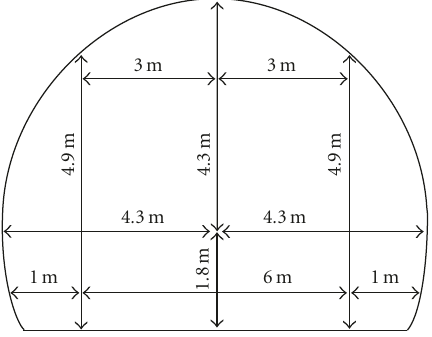
Figure 1: Cross-section of the tunnel.